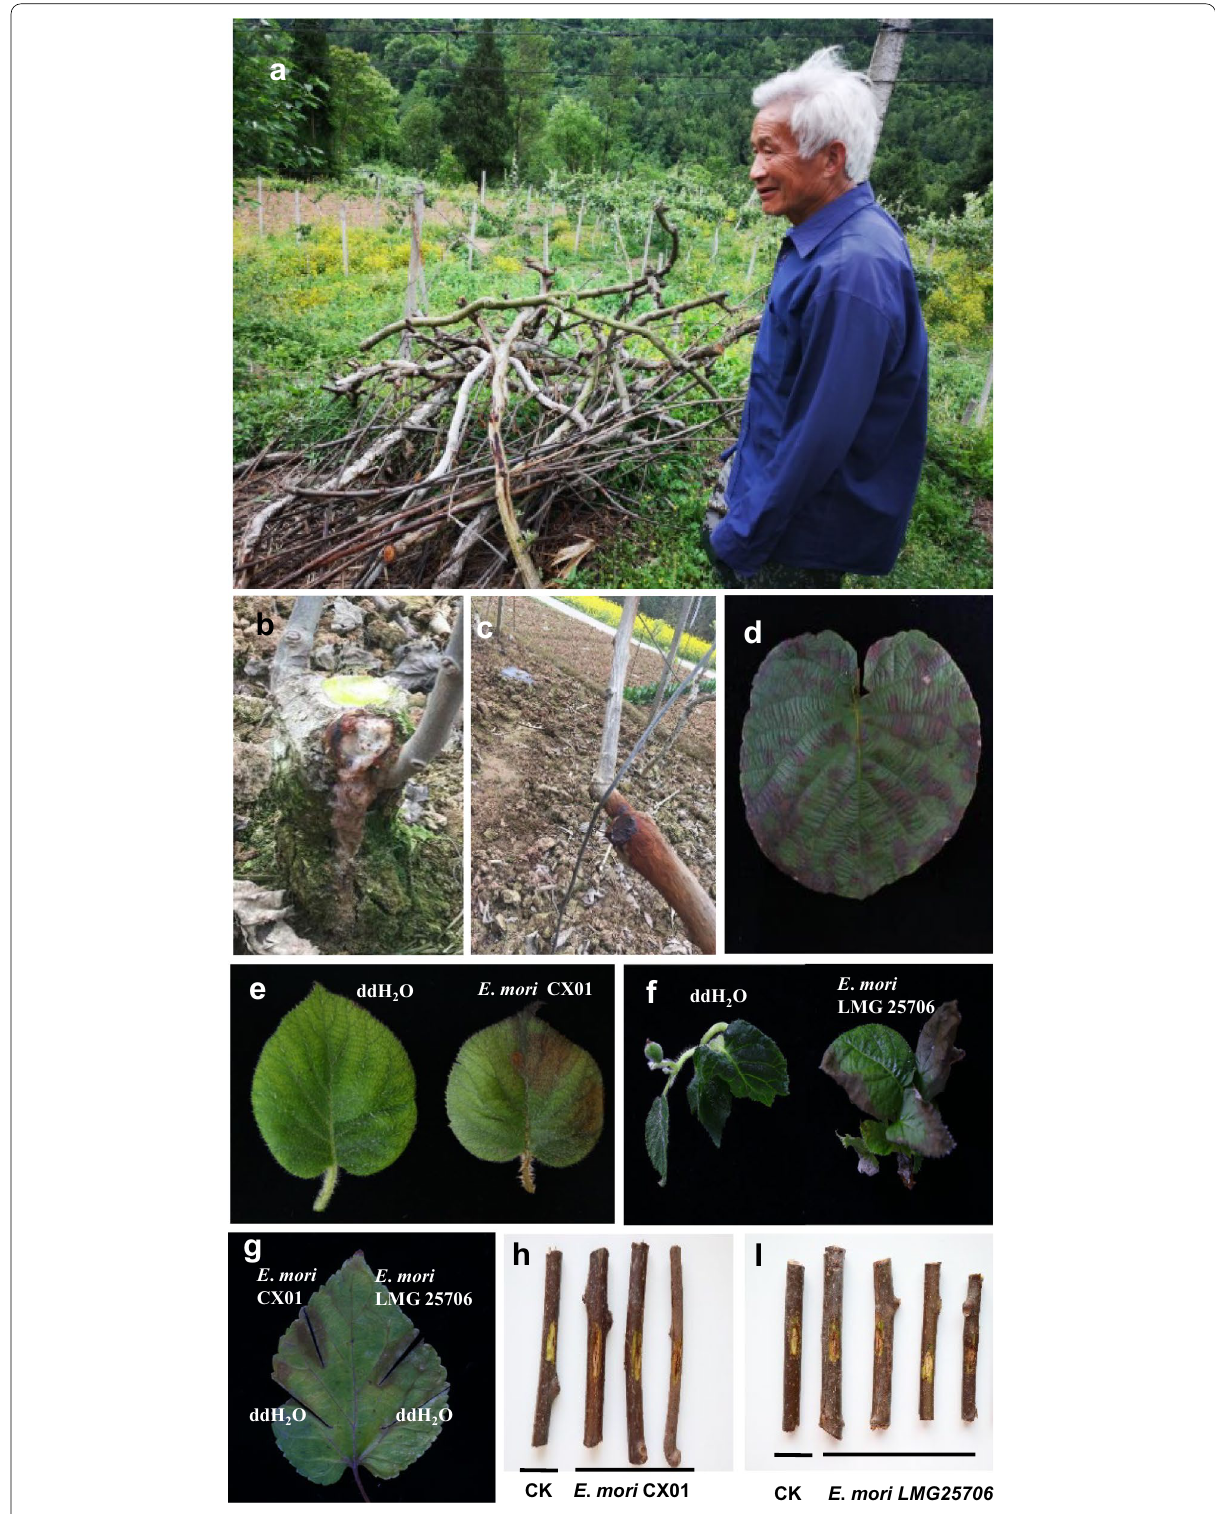
Fig. 1 (See legend on previous